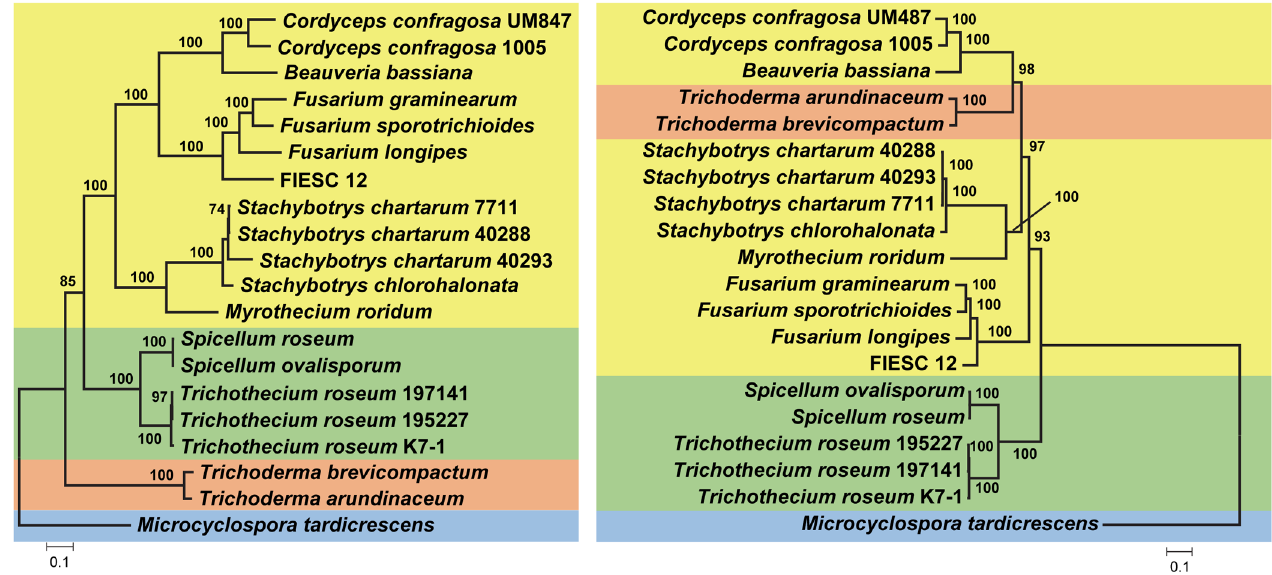
Fig 9. Comparison phylogenetic tree inferred from concatenated sequences of TRI3 , TRI5 and TRI14 (left) and a species phylogeny inferred from concatenated sequences of 20 housekeeping genes (right). Numbers near branch nodes are bootstrap values from 1000 pseudoreplicates. Only bootstrap values greater than 70% are shown. The housekeeping genes used in this analysis are listed in S3 File.